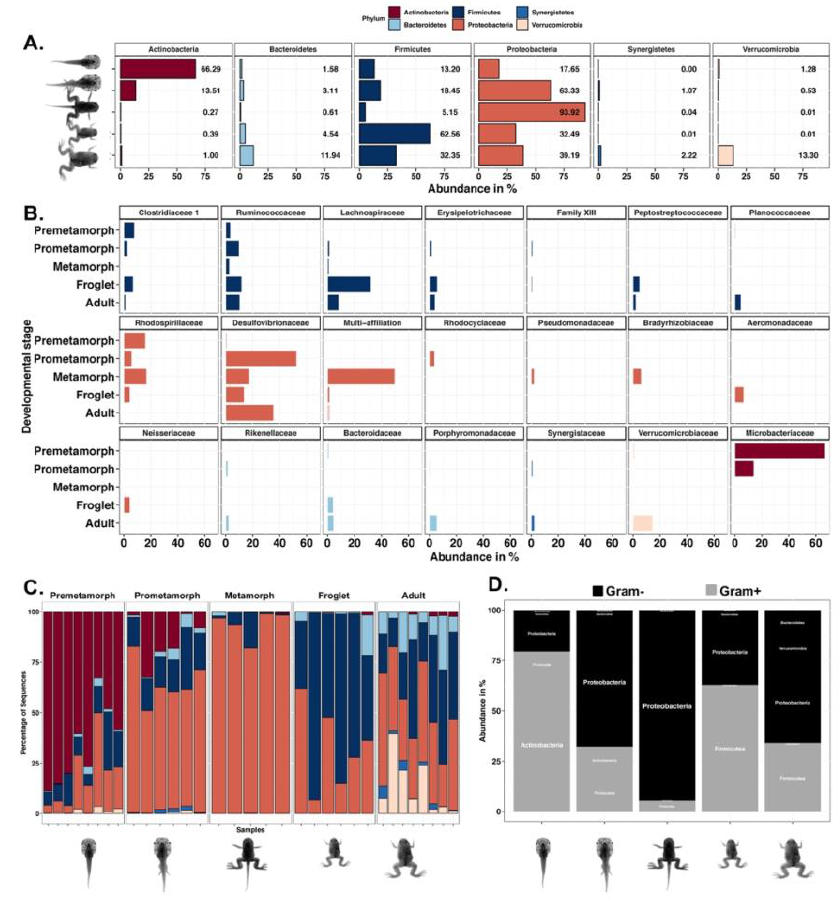
Figure 2. Phylum and Family-level compositional changes in the Xenopus gut microbiome across development. A. Bar plot representation of bacterial diversity at the phylum level. Results for the different life stages studied are shown in the following order, from top to bottom: Premetamorphic tadpoles (NF54 to NF56); Prometamorphic tadpoles (NF58 to NF61); Metamorphic tadpole (NF 62); Froglet (NF66); Adult: sexually mature adults (males and females). B. Bar plot representation of bacterial diversity at the family level, in the same order as A. C. Same as A but viewed at the sample level to highlight interindividual differences. D. Bar plot representation of Gram-positive and Gram-negative bacterial